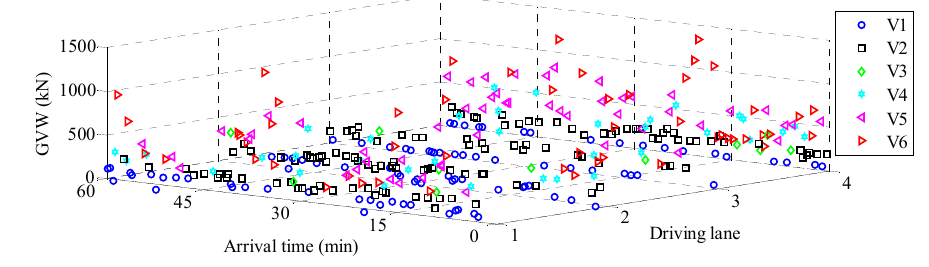
Figure 10. Stochastic load model for dense traffic flow.